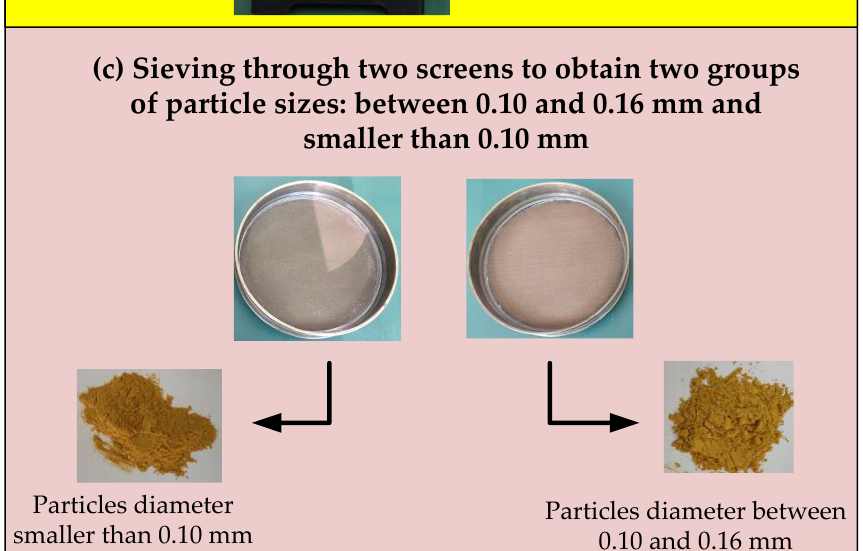
Figure 2. Preparation of Mandarin Peel Powder.